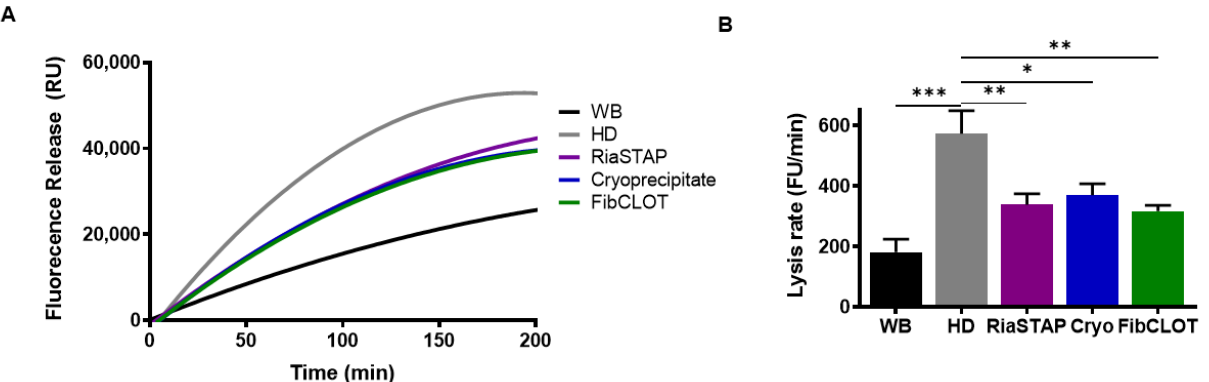
Figure 8. Fibrinogen supplementation stabilizes thrombi formed at hemodilution against fibrino lysis. ( A ) FITC-fibrinogen (43.5 µg/mL) was added to whole blood (black) or 40% HD blood in the presence of 1mg/mL FibCLOT ® , RiaSTAP ® or cryoprecipitate. The thrombi were formed by recalcification (10.9 mM CaCl 2 ) and rotated on at 30 rpm for 90 min. The thrombi were lysed with tPA (1 µg/mL), and lysis was measured as fluorescence release of degradation products. ( B ). The thrombus lysis rate was calculated by change in fluorescence unit (FU) per minute. * p < 0.05, ** p < 0.01, *** p < 0.001 vs. HD. n = 3.